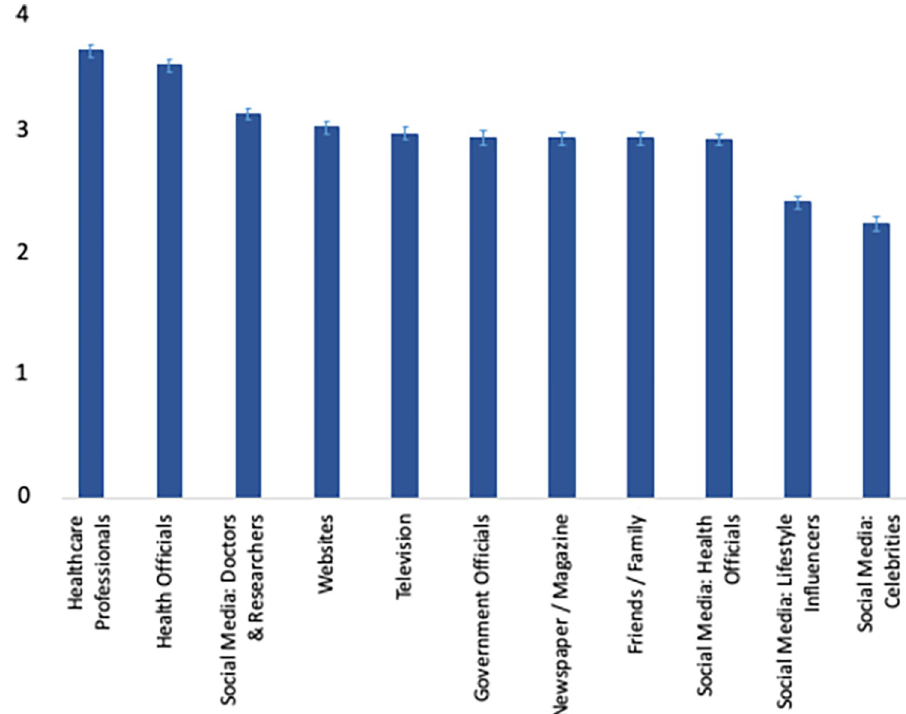
Fig 1. Mean reliability in information